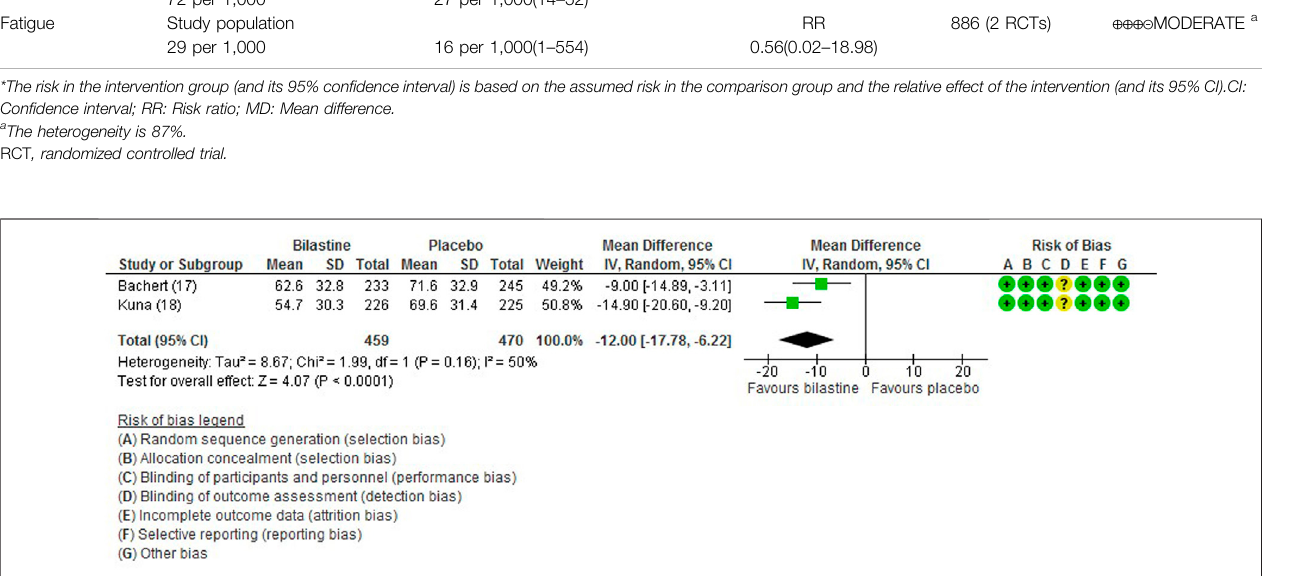
FIGURE5| Comparison betweenbilastineandplacebofornasalsymptomscore. SD Standarddeviation, IV inversevariance, CI Con fi denceinterval, df degreesof freedom.